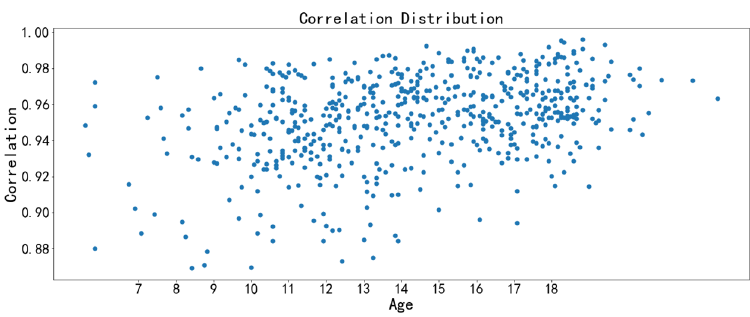
Figure 9. Scatter diagram between correlation with chronological age (females).